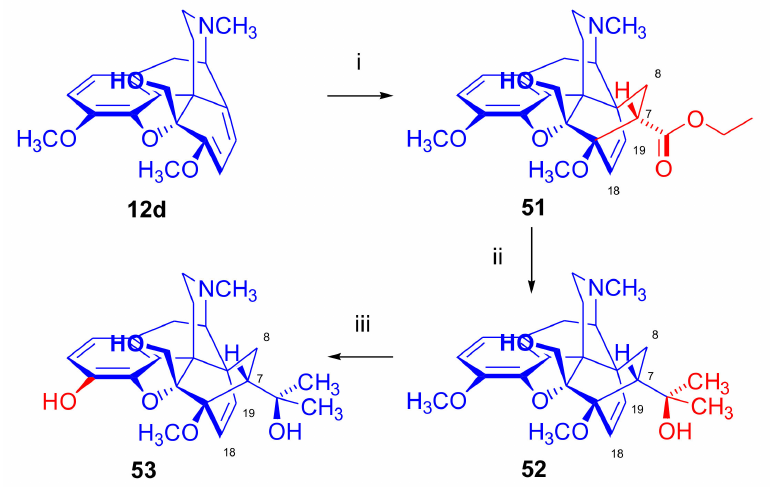
Figure 17. Synthesis of the 5 β -methanol analogue of 20-methylorvinols. Reagents and conditions : (i): ethyl acrylate, reflux, one week, (ii): methylmagnesium iodide, benzene, diethyl ether, and (iii): KOH, ethylene glycol, microwave heating, 6